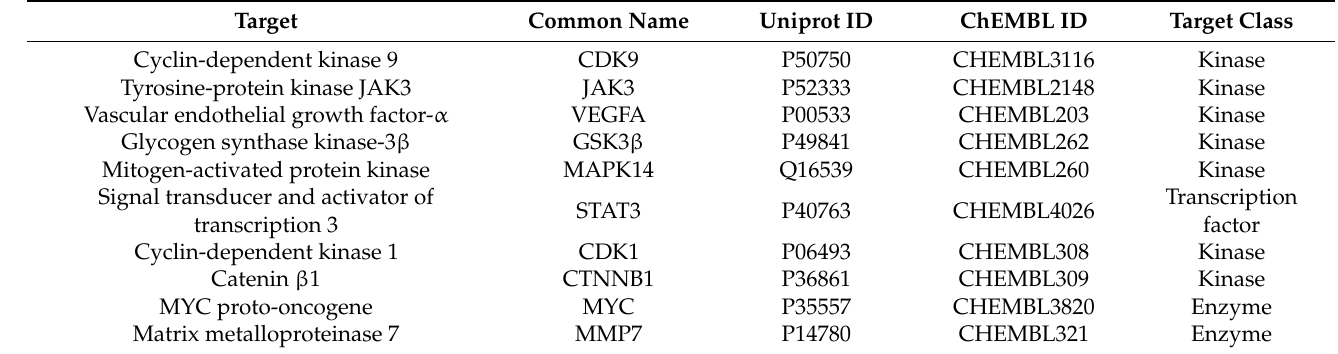
Figure 4. LCC-21 small molecules passed the minimum requirements for drug-likeness, medicinal Figure 4. LCC ‐ 21 small molecules passed the minimum requirements for drug ‐ likeness, medicinal chemistry, and ADME. ( A ) Physiochemical properties of LCC-21 represented on a bioavailability chemistry, and ADME. ( A ) Physiochemical properties of LCC ‐ 21 represented on a bioavailability radar. ( B ) BBB permeability of LCC-21 (with 0.02 score). Table 1. Shows the specific protein targets of radar. ( B ) BBB permeability of LCC ‐ 21 (with 0.02 score). Table 1. Shows the specific protein targets LCC-21. of LCC ‐ 21. Table 1. Common names, Uniprot and ChEMBL identifications (IDs), and target classes of specific protein targets of